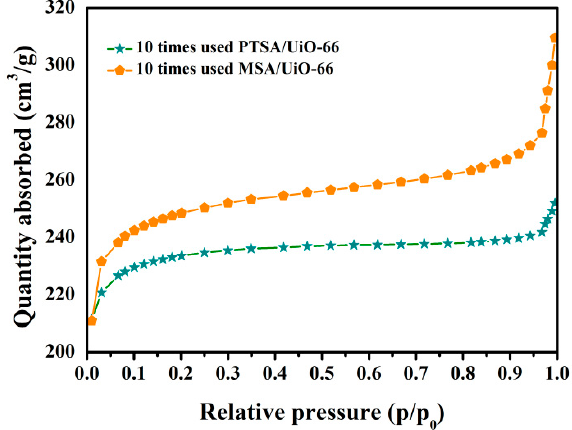
Figure 9. N 2 adsorption-desorption of used solid catalysts.